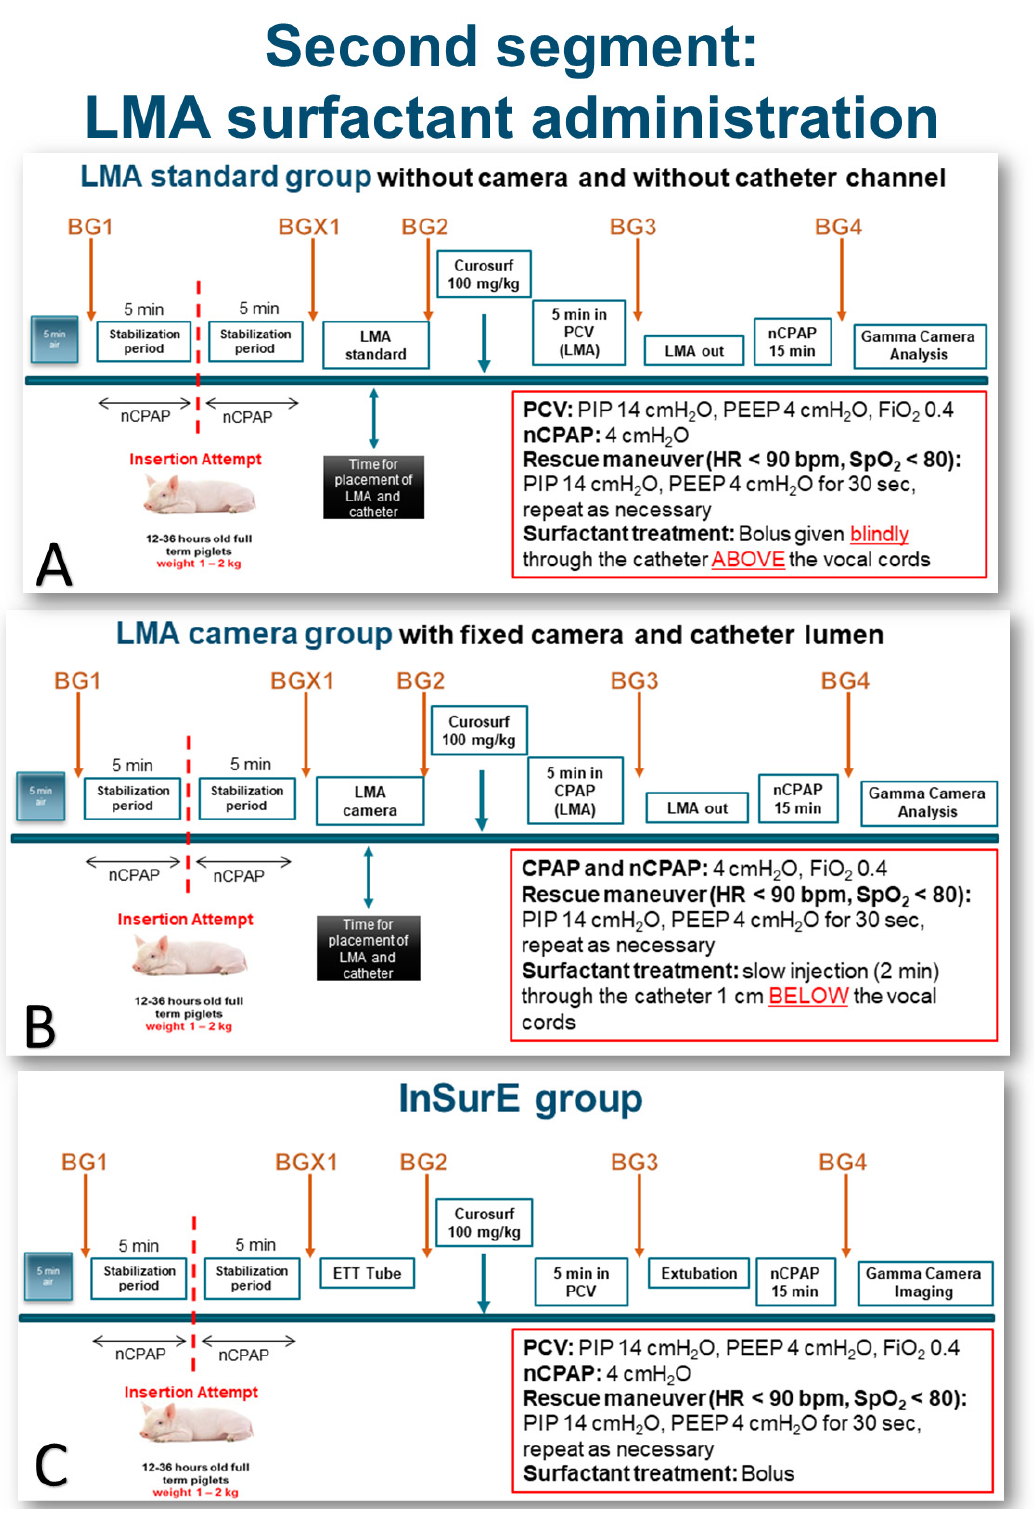
Figure 3. Summary of the second segment of the experimental protocol “LMA surfactant administration”. Panel ( A ), LMA standard group; panel ( B ), LMA camera group; panel ( C ), InSurE group. LMA, laryngeal mask airway; BG, blood gas; CPAP, continuous positive airway pressure; nCPAP, nasal CPAP; FiO 2 , inspired fraction of oxygen; HR, heart rate; SpO 2 , peripheral oxygen saturation; PIP, peak inspiratory pressure; PEEP, positive end-expiratory pressure; PCV, pressure-controlled ventilation; ETT, endotracheal tube.